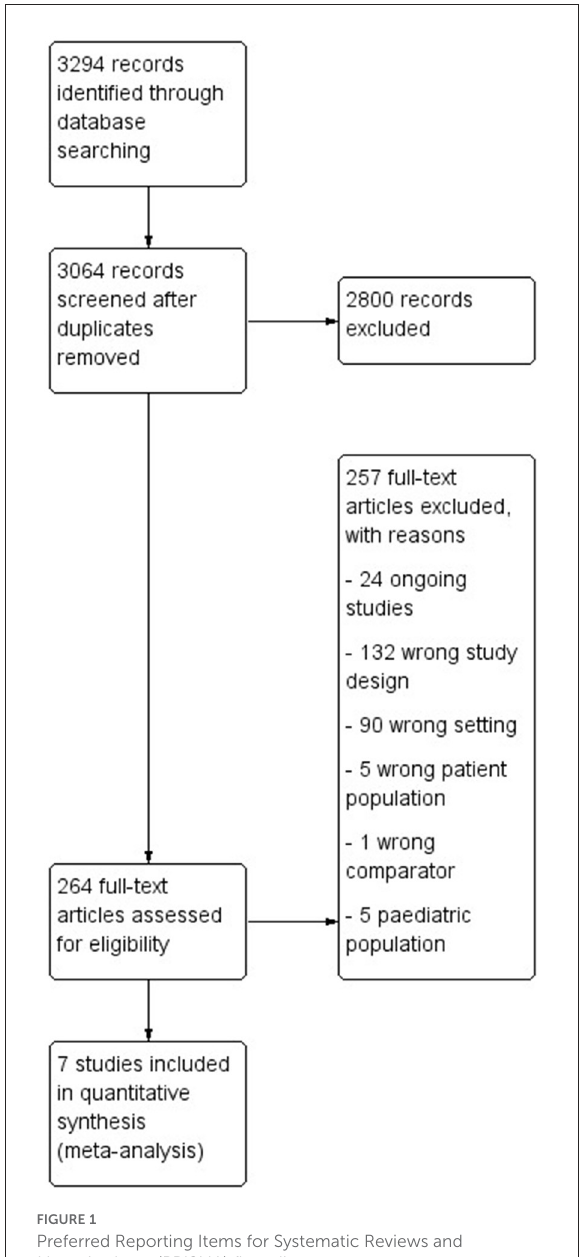
FIGURE1 Preferred Reporting Items for Systematic Reviews and Meta-Analyses (PRISMA) flow